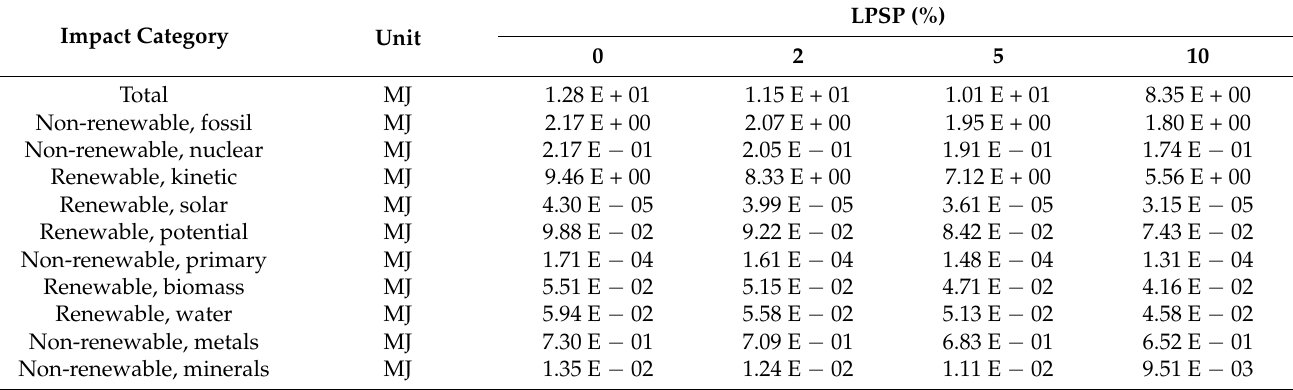
Table 2. CExD for producing 1 m 3 freshwater by SWROD/WT/BBS in various impact categories when the battery is full. Impact Category